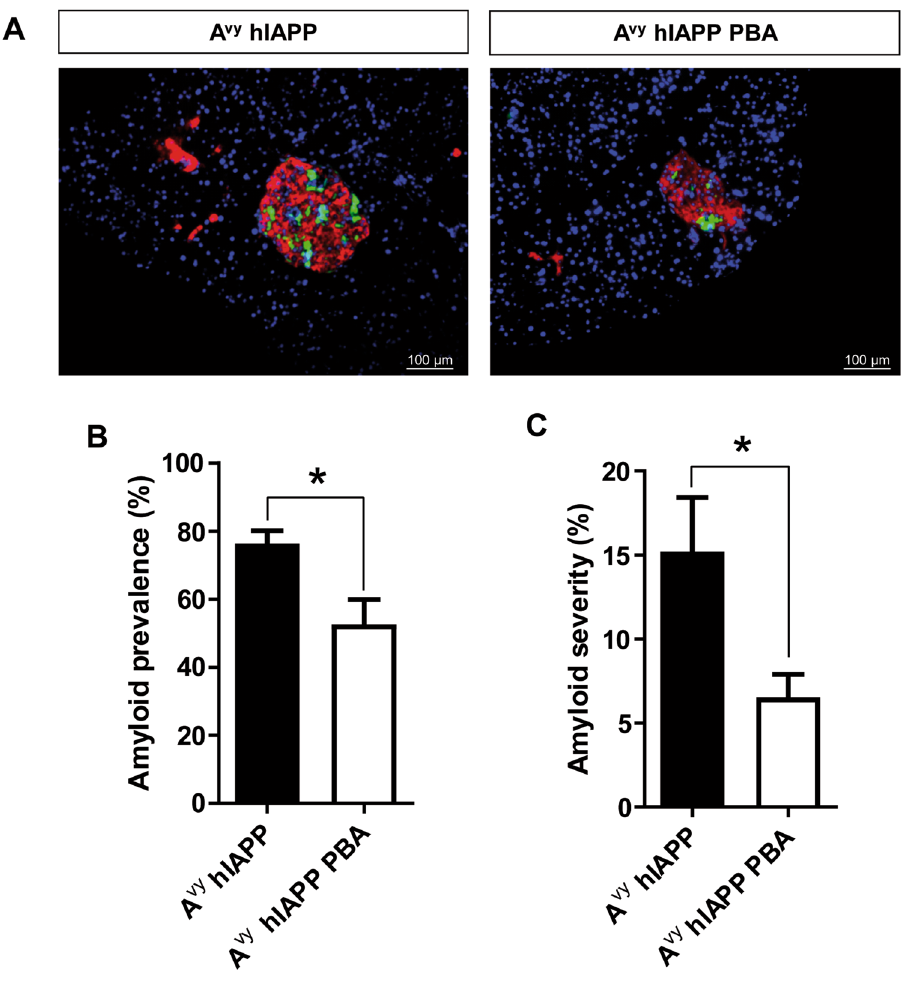
Figure 5. PBA treatment prevents amyloid formation in A vy hIAPP mice. (A) Representative images of islets from 20-week-old A vy hIAPP mice after 12 weeks of treatment with oral PBA. Non-treated mice were used as controls. Pancreas sections were stained with Thioflavin S to detect amyloid deposits (green), an anti-insulin antibody (red), and Hoechst 33,342 (blue). Scale bars, 100 μm. (B) Amyloid prevalence (% of islets with amyloid) and (C) amyloid severity (% of amyloid to total islet size). Results are presented as mean ± SEM of 7–8 mice/group, from 2 independent experiments. Statistical analyses were performed using Student’s t-test. *p <